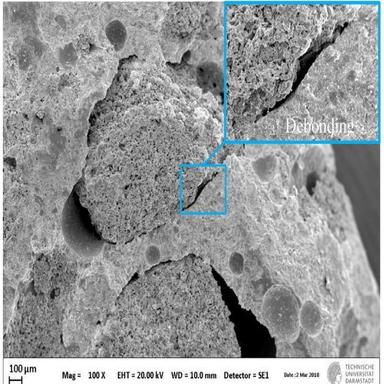
SEM analysis of the SB-80 mortar.